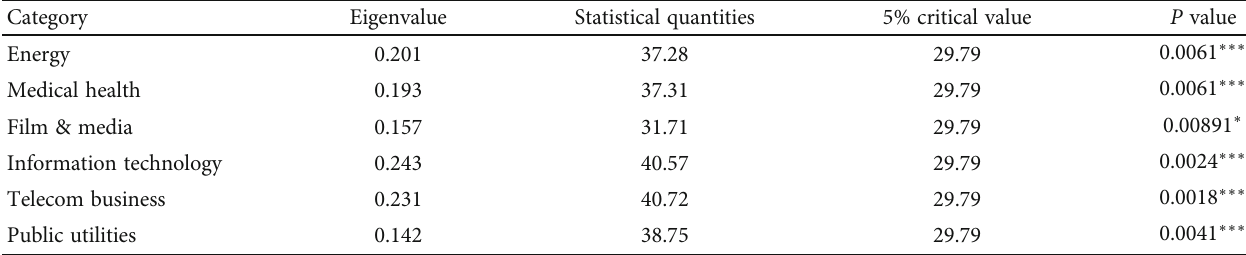
Table 7: Industry index and economic cycle cointegration test results.